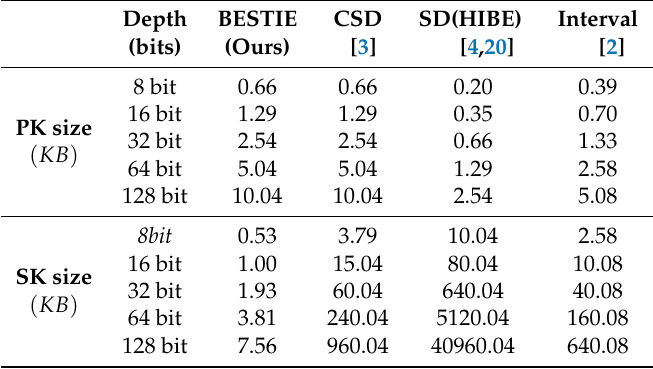
Table 2. Key size of BESTIE, CSD, SD, and interval